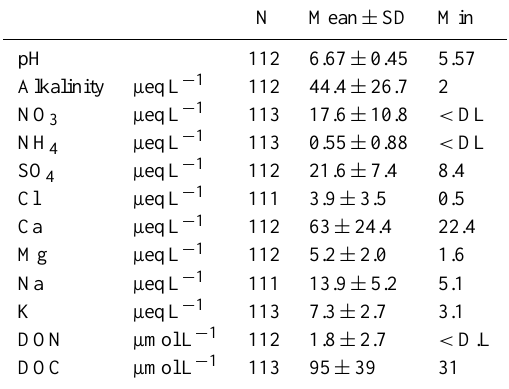
Table 4. Mean ± standard deviation of pH and concentrations (µmolL − 1 ) of the major chemical species measured at 16 sites dur- ing 2007 and 2008.